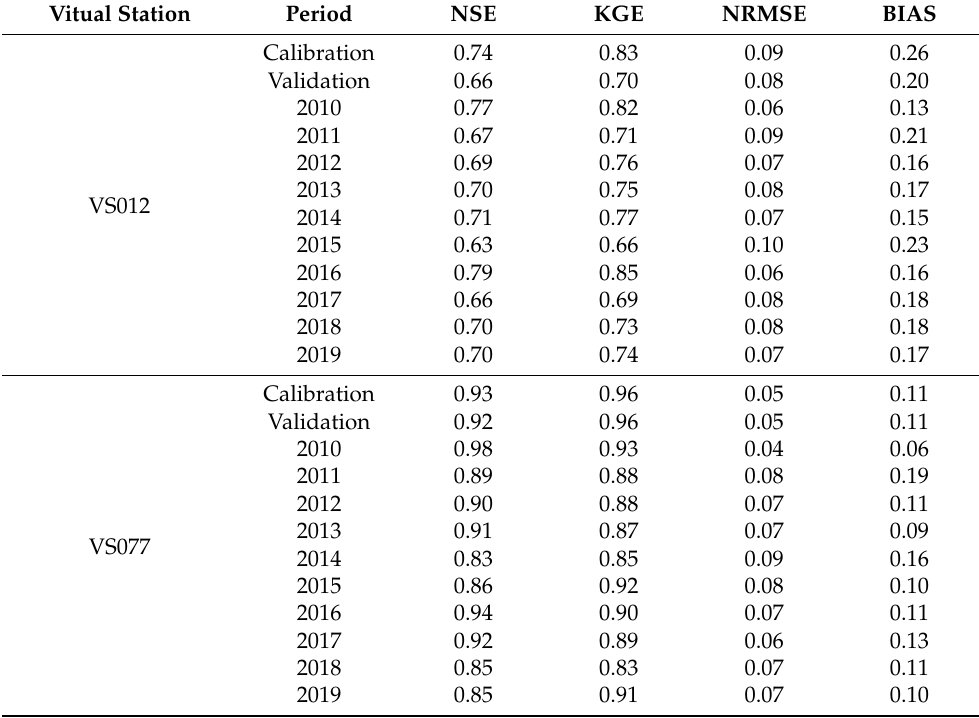
Figure 5. Simulated discharge from satellite radar altimetry at ( a ) VS012 and ( b ) VS077 between 2008 and 2019. Note: The white background area is the calibration results of the developed Manning formula and the grey shaded area represents the validation results. The black solid and dashed lines represent the observed discharge during the calibration and validation periods, respectively; the red circle and triangle mean the simulated results during the calibration and validation periods, respectively. Table 1. Comparison between simulated discharge from satellite radar altimetry at VS012 and VS 077 between 2008 and